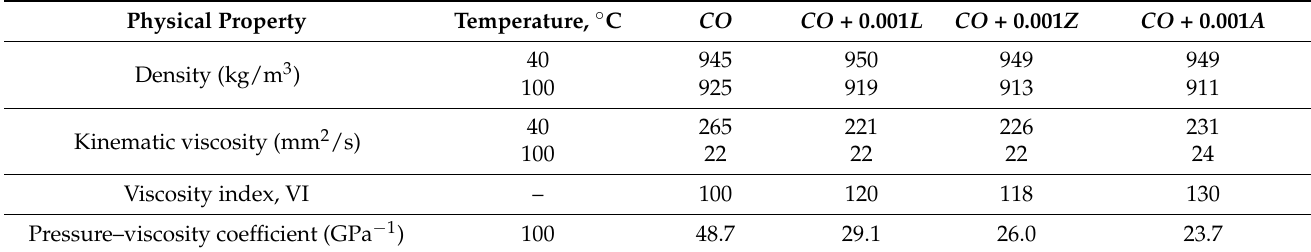
Table 2. Physical properties of